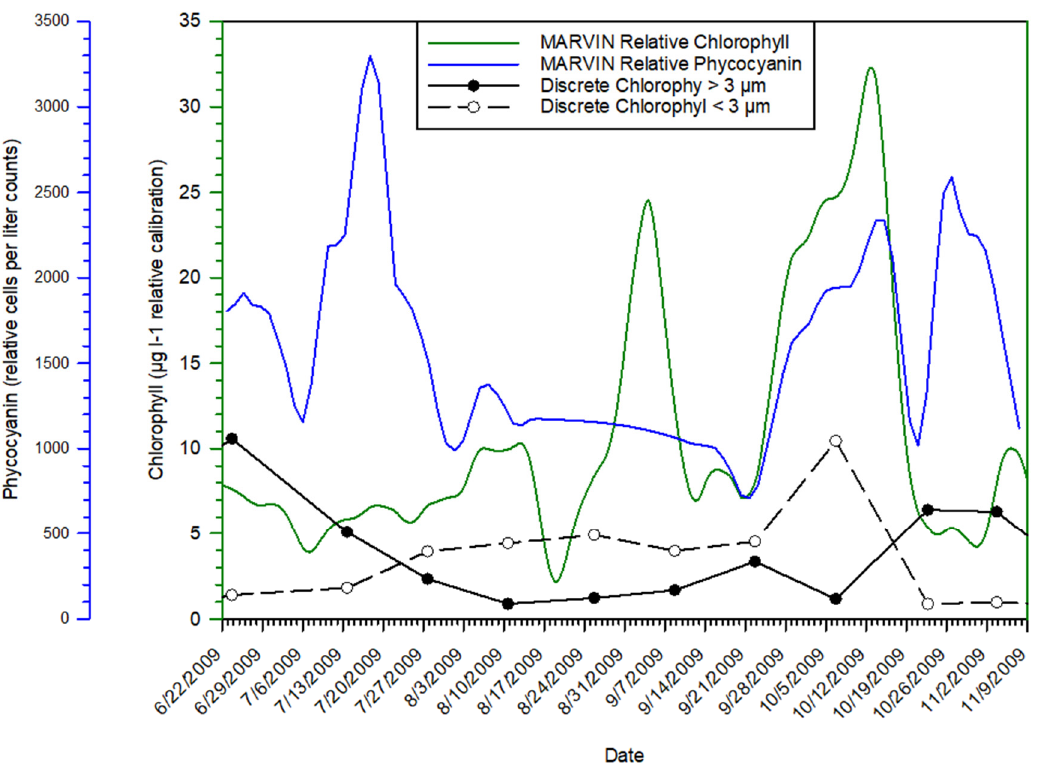
Figure 6. The time series of chlorophyll concentrations and phycocyanin fluorescence from the MARVIN platform compared to values determined in discrete size-fractionated samples.